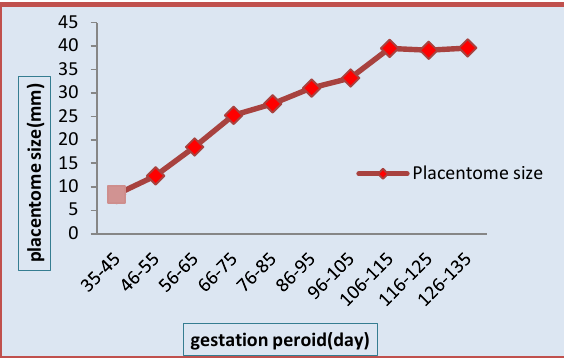
Figure, 1: Relationship between placentomes development and Gestation age in does.